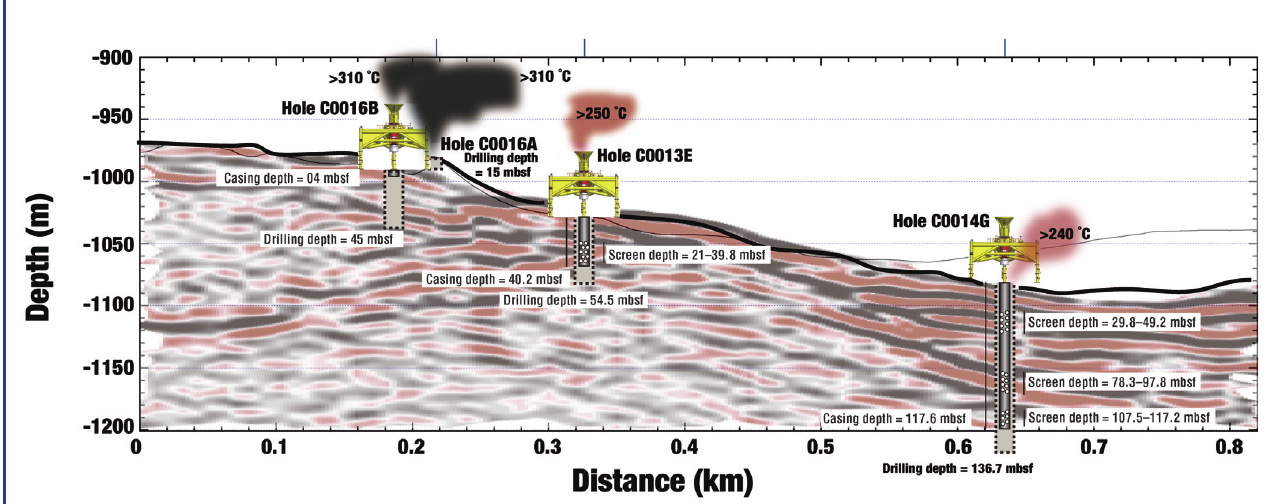
Figure 4. Schematic illustration of post-drilling natural and artificial hydrothermal vents created during Expedition 331. Outflow temperatures measured by ROV (Hole C0013E) and thermal stickers (Holes C0014G and C0016B). Modified from Takai et al.